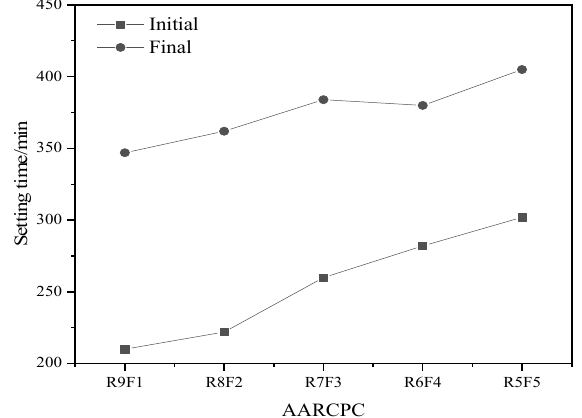
Figure 2. Setting time of AARCPC with different fly ash content.